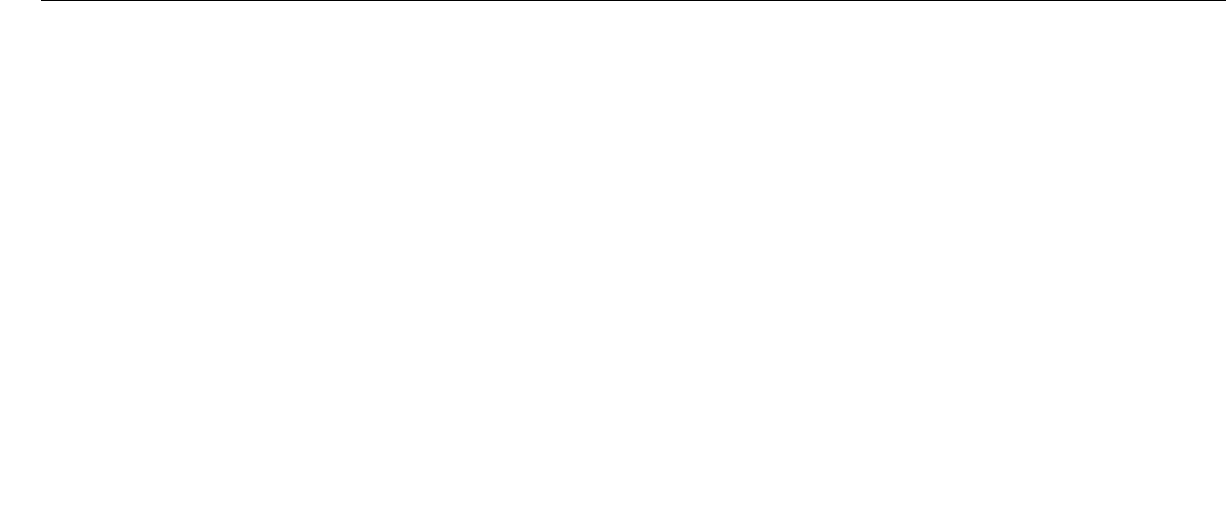
Fig. 14 Experiment results experiment No. EXP 5F2, of GIII sample. a Pore water pressure and vertical displacement curves b Hydraulic gradient and TSS